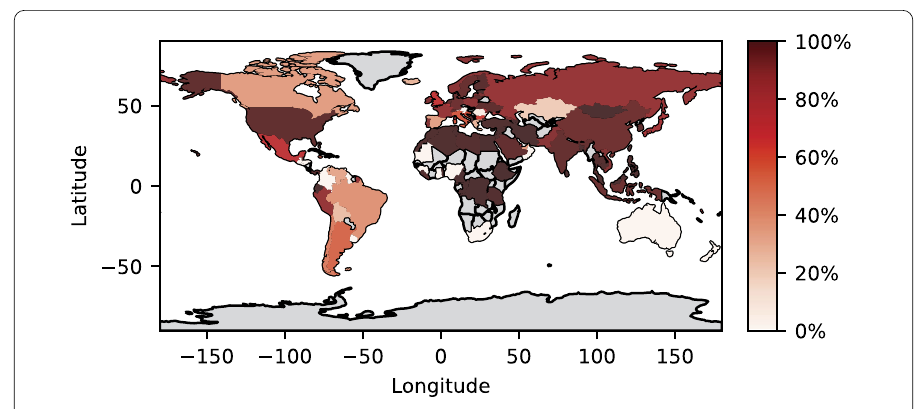
Figure A3 The fraction of noncompliant ships for each flag state. Countries without any ships registered to it, are shown in grey